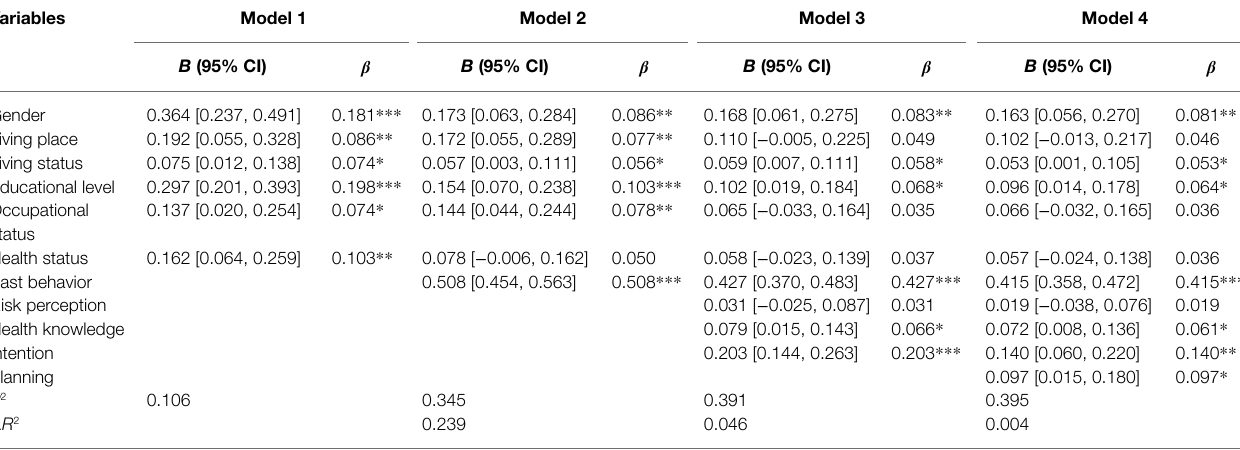
TABLE 4 | Hierarchical regression analysis with hand washing behavior ( N = 928).